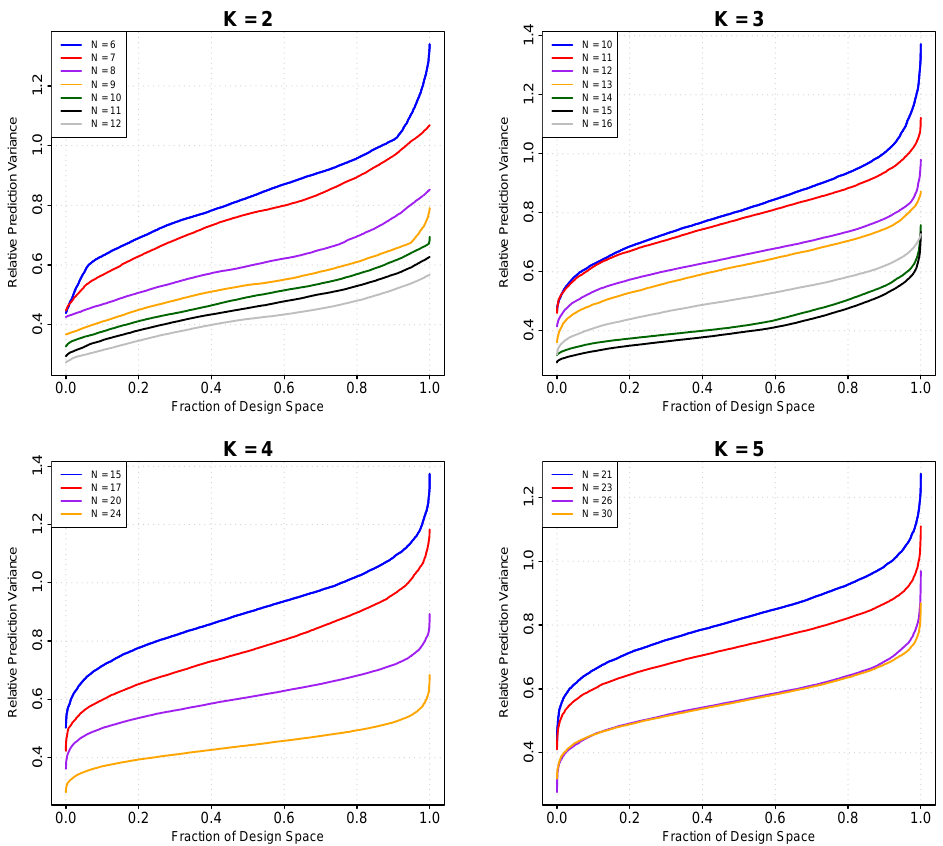
Figure 3. Fraction of Design space plots (relative prediction variance) for the G -efficient designs generated in this